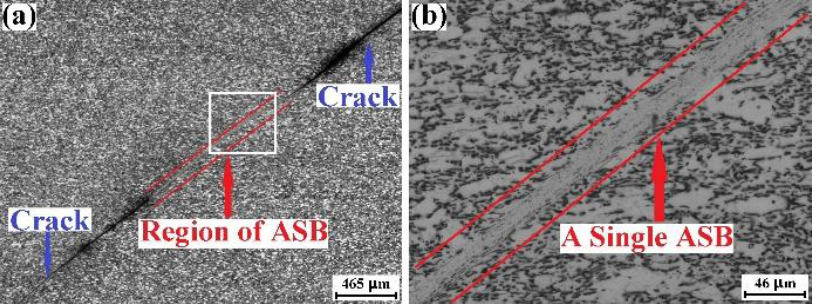
Figure 10. Optical micrographs regarding the adiabatic shearing behavior of mill-annealed Ti-6Al-4V alloy plate compressed in the ND. The loading direction is vertical. ( a ) Optical micrograph for the ASB and the crack induced by the ASB, ( b ) high-magnification optical micrograph for the rectangle region of Figure 10a.